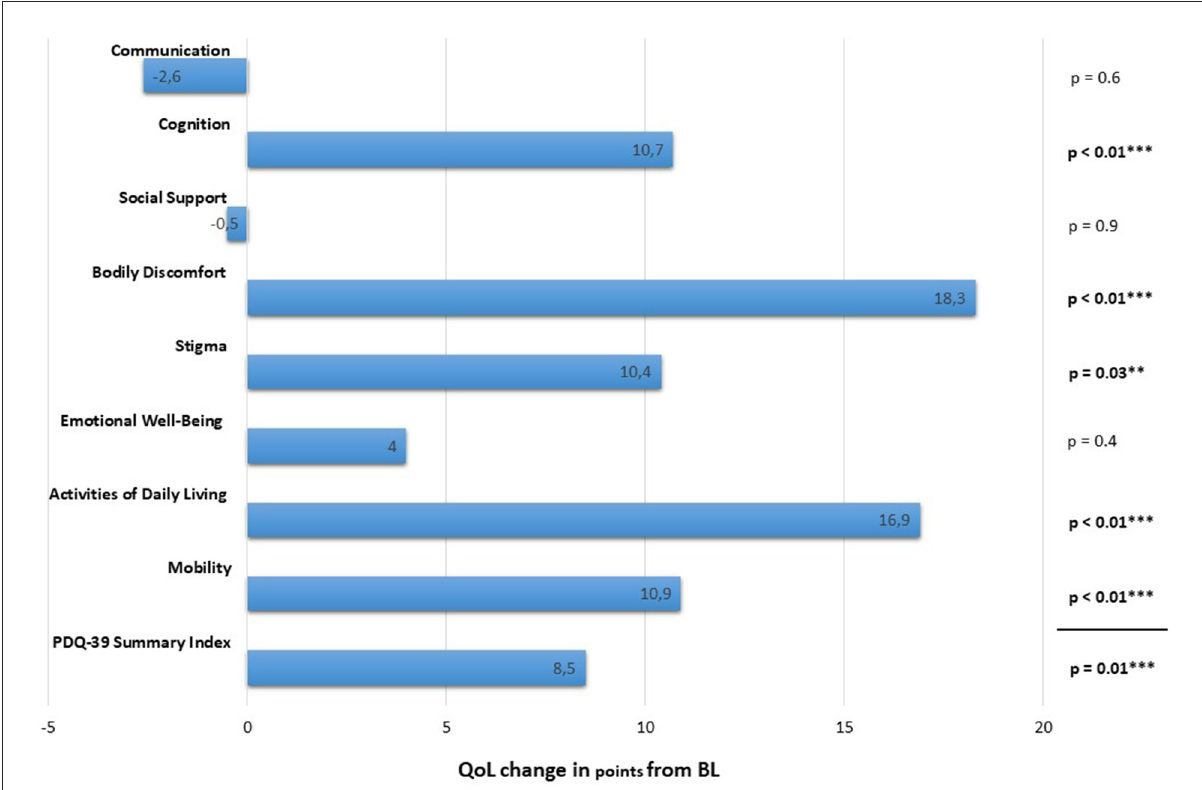
FIGURE1 Quality of life as assessed by means of the Parkinson’s Disease Questionnaire (PDQ-39) comparing absolute changes from baseline (BL) to 12 months follow-up (12-MFU) in all Early-Onset Parkinson’s Disease patients with available pre- and postoperative scores ( n = 33). Each column depicts the absolute change of subscores for the various domains of the PDQ-39 after 12 months of DBS. The first column indicates the overall absolute change in the summary index of the PDQ-39 at 12-MFU. Positive values indicate improvement. *highlights statistically significant changes * p ≤ 0.05; ** p ≤ 0.03; *** p ≤